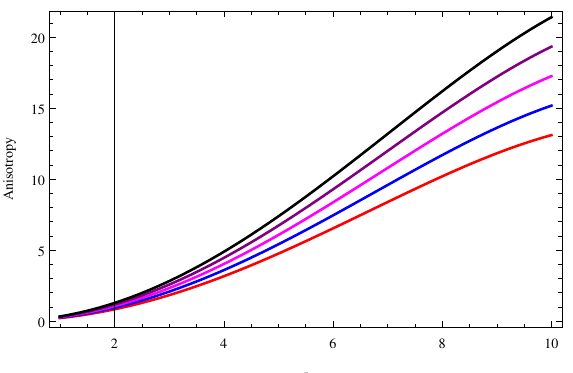
Figure 3. Plot of anisotropy versus r for the strange star candidate LMC X − 4. The red, purple, magenta, blue and black colors represent respectively cases (cid:118) = 0, (cid:118) = 0.5, (cid:118) = 1, (cid:118) = 1.5 and (cid:118) = 2.